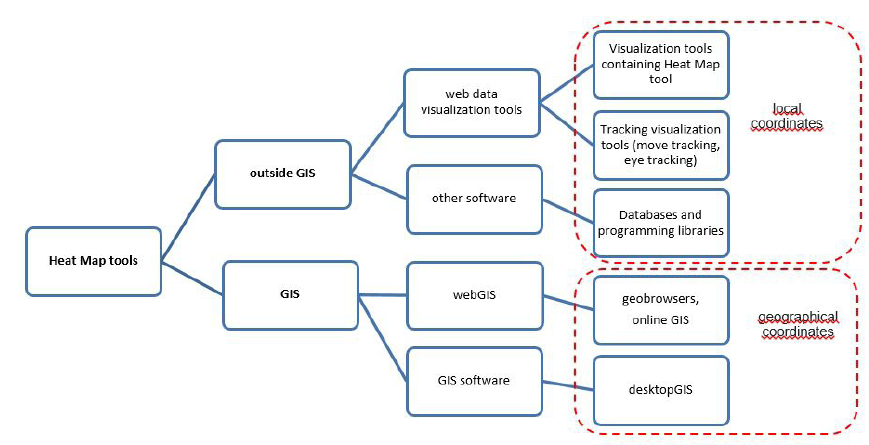
Fig. 4. Division of Heat Map tools and applications